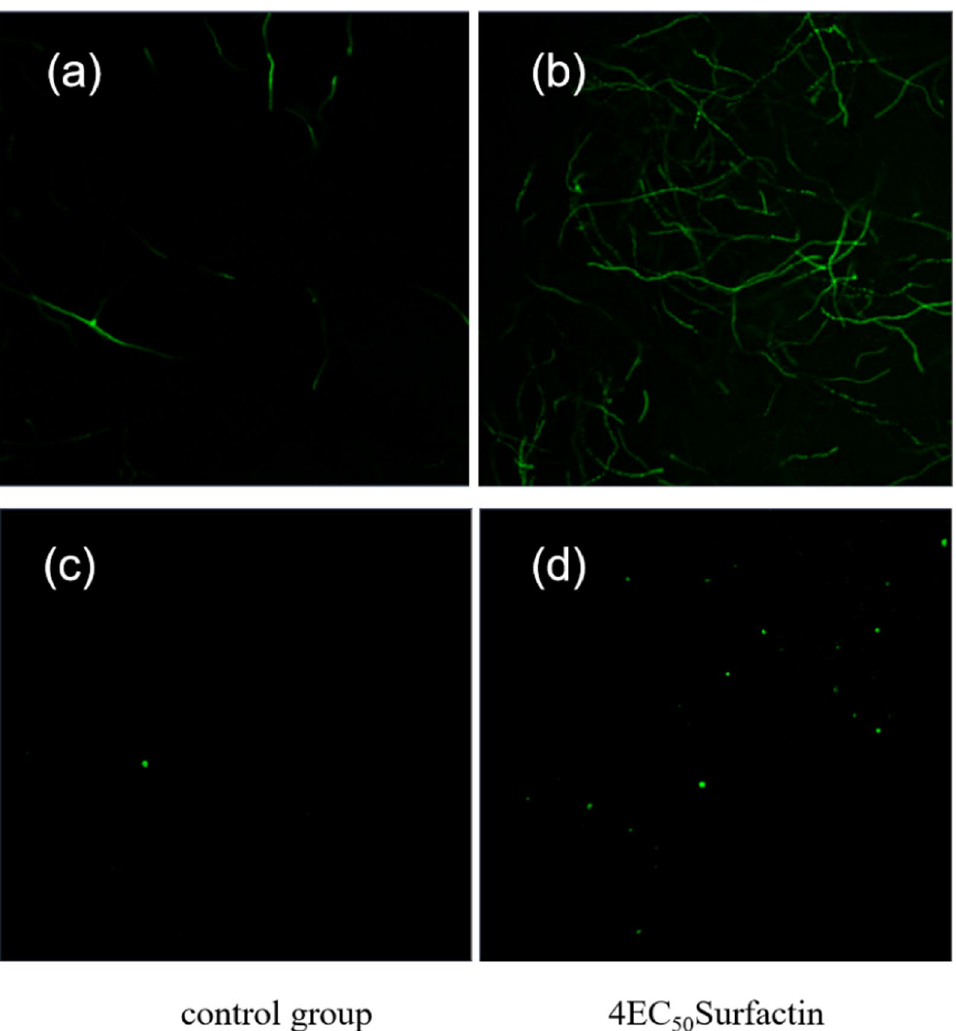
Fig. 8 Different ROS contents of mycelia ( a , b ) and spores ( c , d ) of B. cinerea in the control and 4 EC 50 surfactin groups. Images were obtained by laser scanning confocal microscopy at 10 ×